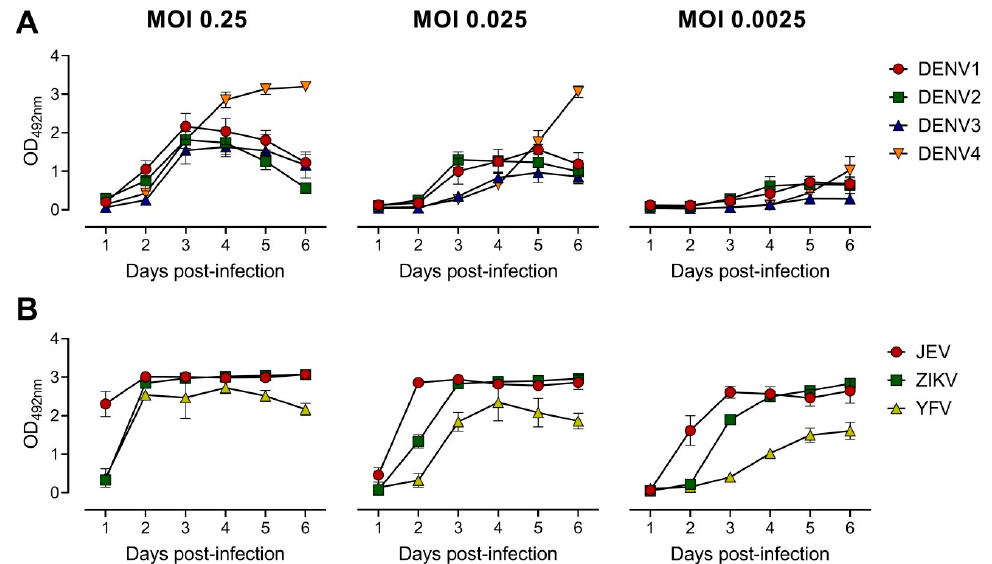
Figure 1. Quantitation of optical density (OD 492nm ) induced in BHK-21 cells post virus infection. BHK-21 cells were infected with virus at di ff erent MOIs as indicated. OD 492nm values were determined at 1 through 6 days post-infection. Growth curves of DENV 1–4 ( A ) and other flaviviruses: JEV, ZIKV and YFV ( B ) in BHK-21 cells were measured by antigen-detection ELISA [37]. Each data point represents the geometric mean value of duplicates ran independently thrice. Error bars depict standard deviation of six replicates.